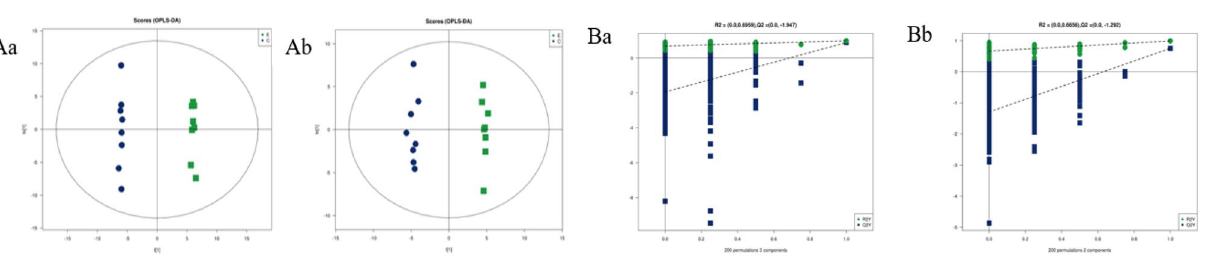
Figure 4. ( A ) LC/MS based OPLS-DA of rat myocardial samples from group C and group E. ( a ) Negative ions in C/E group, ( b ) positive ions in C/E group; ( B ) LC/MS based OPLS-DA permutation test diagram of rat myocardial samples from group C and group E. ( a ) Negative ions in group C/E, ( b ) positive ions in group C/E. Abscissa: permutation retention for permutation tests; Ordinate: the value of R2 or